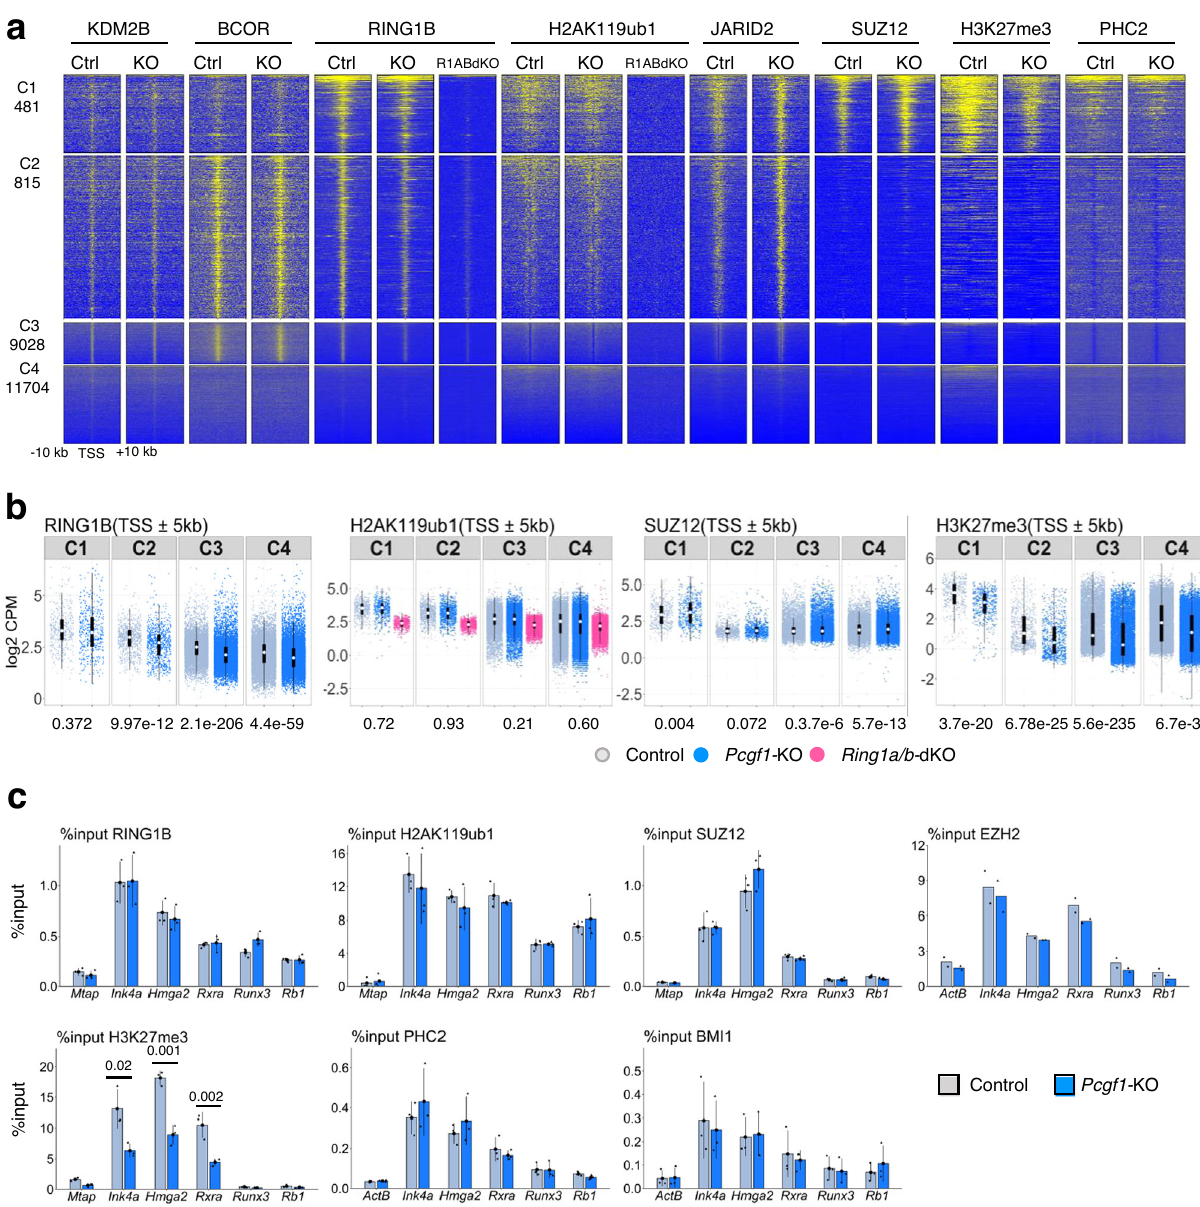
(inthecaseof H2AK119ub1) Ring1a/b- dKOIdHPCs.Dataingraphsrepresentmeans